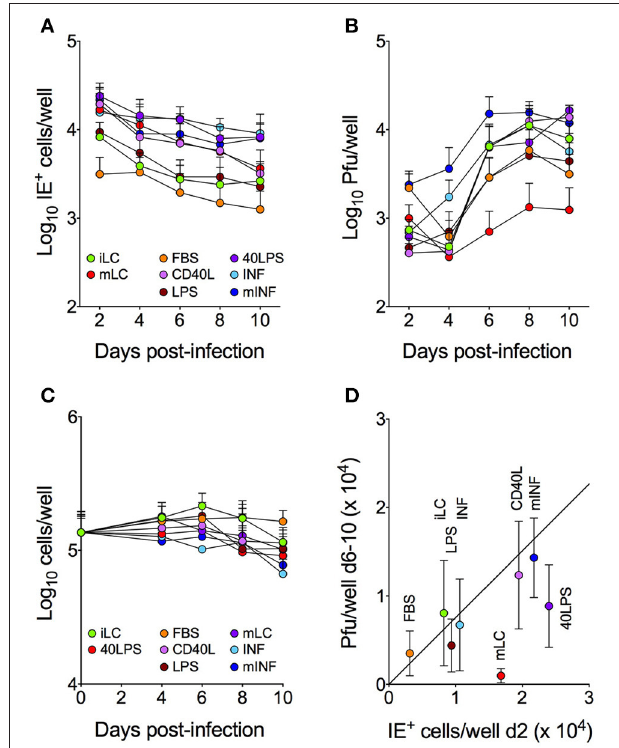
FIGURE 1 | Activation differentially affects the number of IE + cells and progeny yields. LC cultured under eight different conditions were infected with TB40/E at an MOI of 10, and subsequently maintained in each medium for 10 days, with cell and supernatant collections every 2 days. The total number of IE + cells present in each well was determined by immunofluorescence staining analyses (A) , the amount of virus present in each supernatant was assessed by titration (B) and the total number of cells per well was counted (C) . The median number of cells expressing the IE proteins at day 2 was then plotted against the median number of plaque forming units (pfu) present in the supernatants collected from each well at days 6–10 (D) , and the best-fitting line modeling the relationship between the X and Y values of all data points except those of mLC cultures was identified by linear regression ( Y = 0.7 X , R 2 = 0.87). Symbols represent the median and median absolute deviation values of data collected with LC derived from six different CD34 + cell donors in eight independent experiments, from three donors in two independent experiments (C) and from three donors in two independent experiments (40LPS